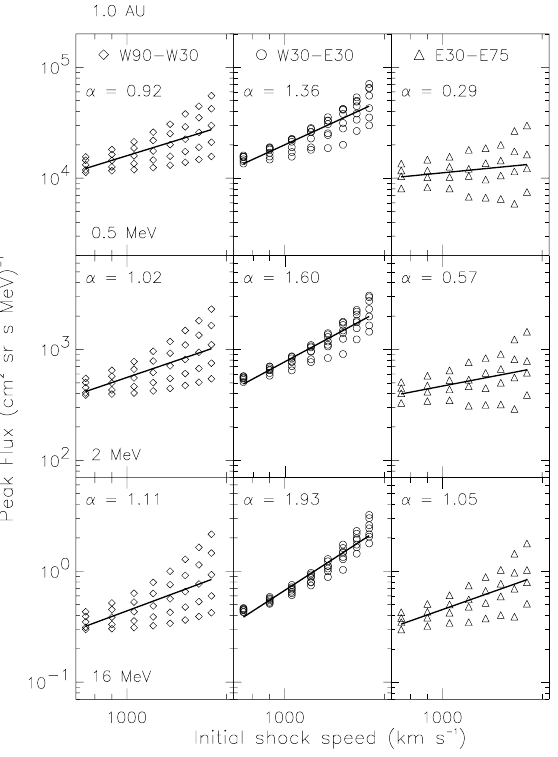
Fig. 3. The correlation between the computed peak flux (f) for 1 AU SEP events and the initial shock speed (v) for 0.5MeV, 2MeV and 16MeV (top, middle and bottom panels, respectively). Each row displays three plots: western, central meridian and eastern events. The black line in each plot depicts the best linear fit to these points and the derived dependence, f ∝ v α , is shown in the upper corner. The values of the peak fluxes are average values calculated as in Fig.